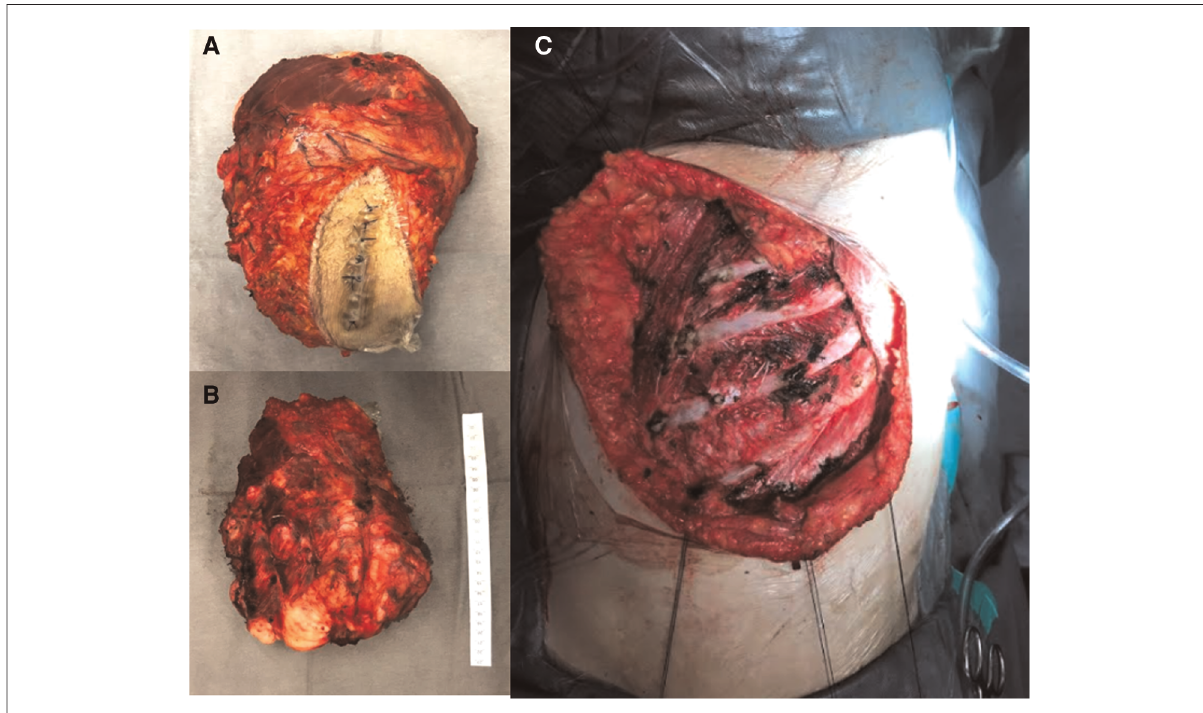
FIGURE 2 Intraoperative images. ( A ) Super fi cial side from the specimen. ( B ) Profound margem. ( C ) Resected